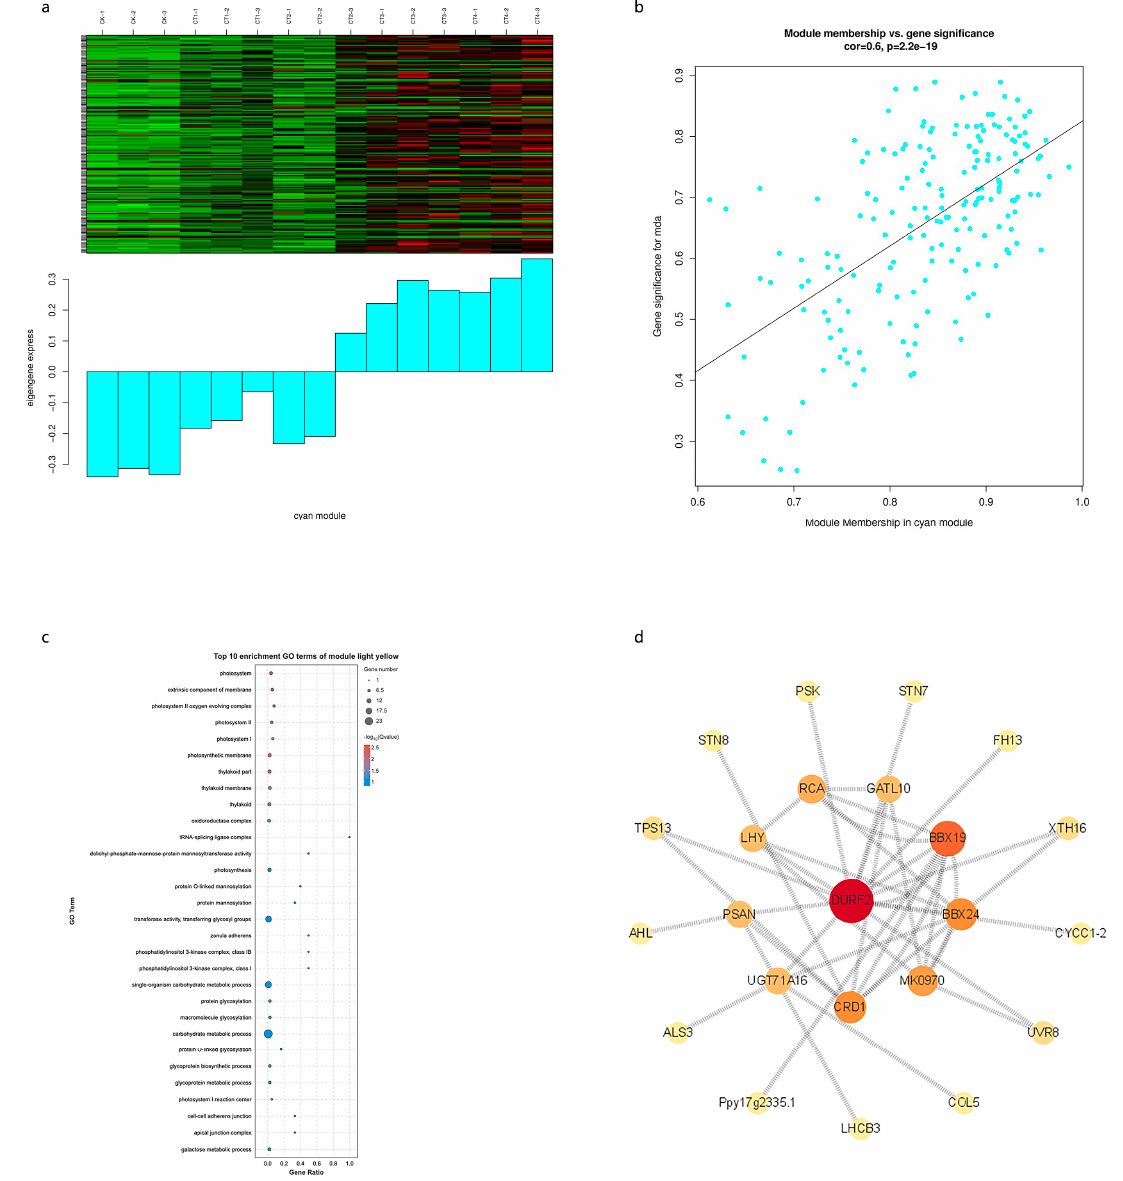
Figure 10. ( a ) Gene co-expression heat map of the cyan module (upper panel) and expression of corresponding signature genes in each sample (lower panel). ( b ) A hub gene dot map showed high connectivity and expressivity for MDA content and the cyan module. The x-axis represents the correlation between the expression of each gene and the module, and the y-axis represents the correlation between each gene and the trait. ( c ) GO analysis of hub genes associated with MDA-related traits in cyan module genes. ( d ) Co-expression network of hub genes in the cyan module. The network was constructed using the top 100 hub genes, with a weight > 0.30.